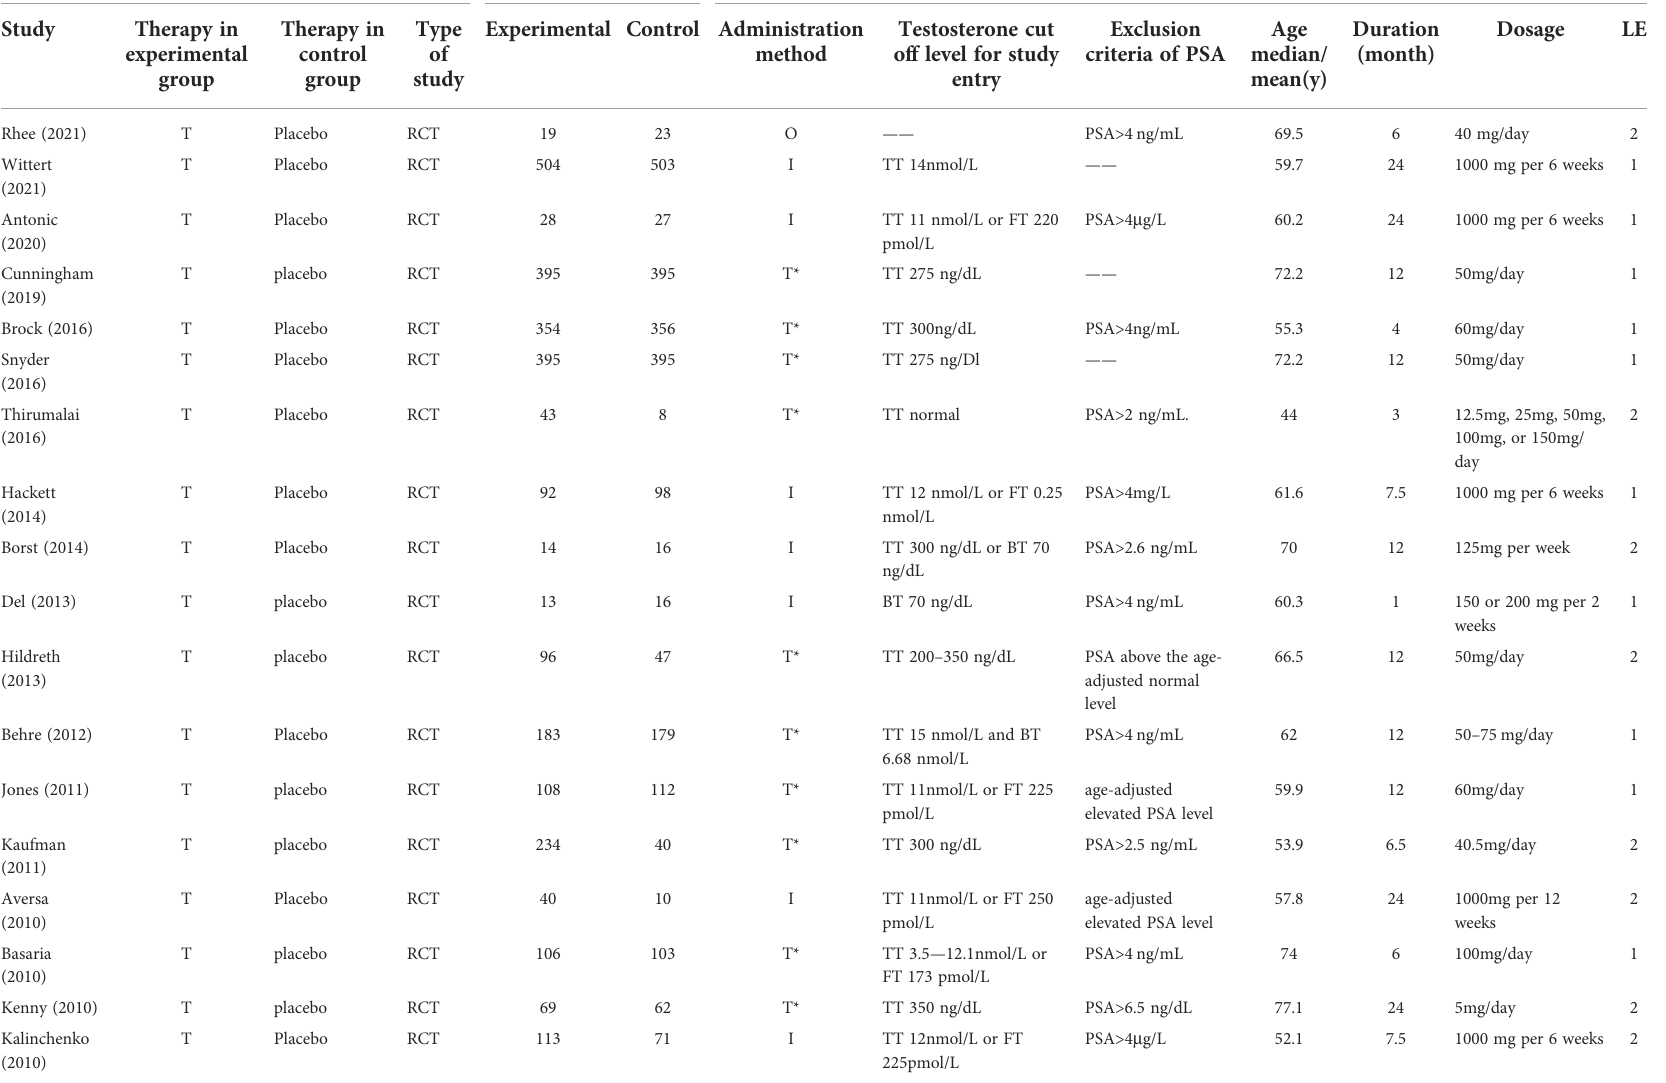
TABLE 1 Characteristics of included studies and